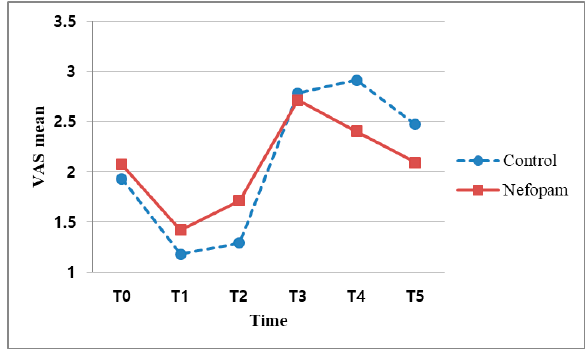
Figure 2. Association between VAS scores and time points. VAS: visual analogue scale; T0: before surgery, T1: immediately after surgery, T2: after surgery 30 min; T3: after surgery 12 h; T4: after surgery 24 h; and T5: after surgery 48 h. Table 2. Association between nefopam and VAS at each time point.